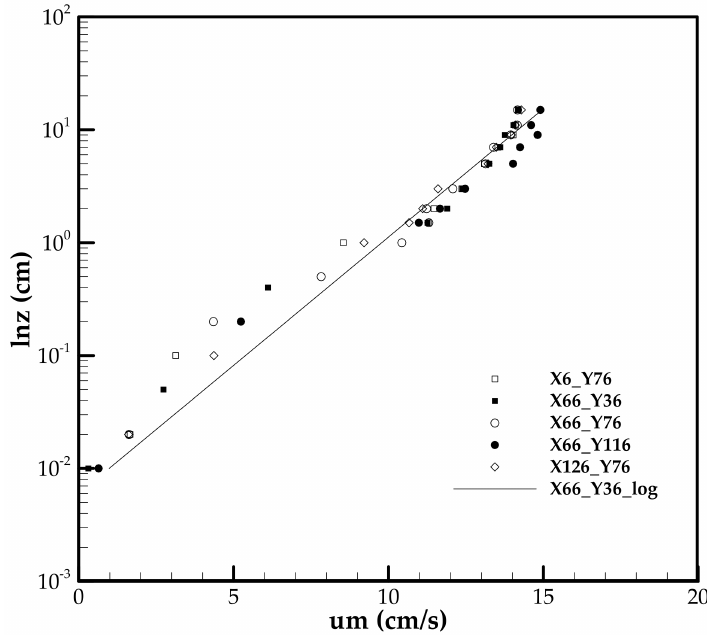
Figure 5. Velocity profiles in semi-logarithmic form for non-vegetated case at different sections of the